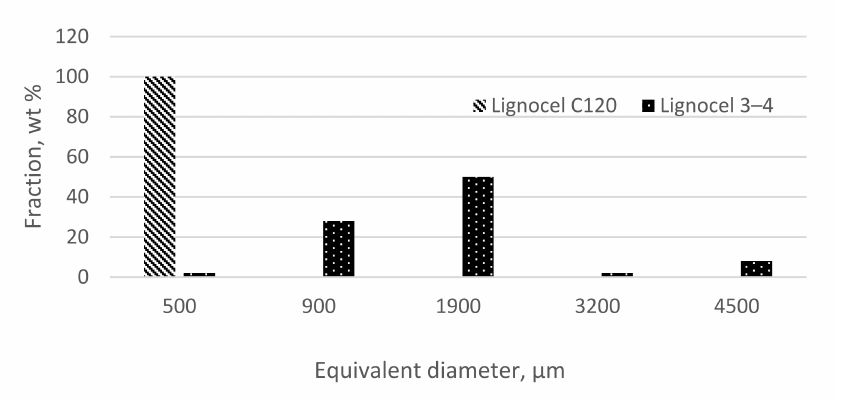
Figure 4. Graph showing the size distribution of the respondents’ wood chips: Lignocel C120 and Lignocel 3-4.